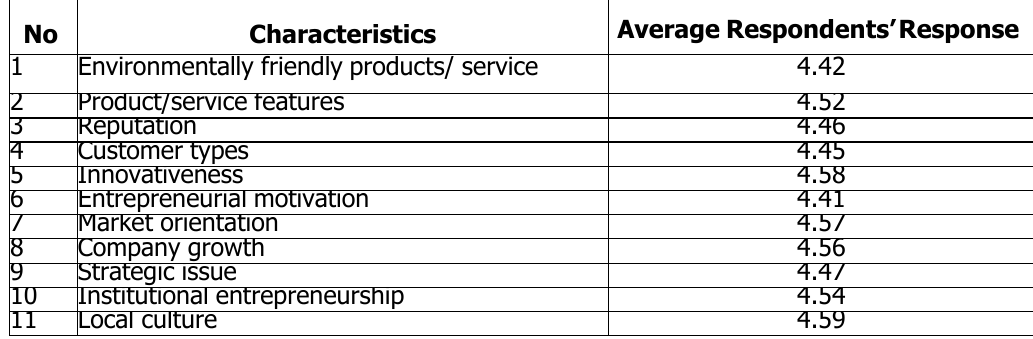
Table 2. On funding for green start-ups, the participant responds. No